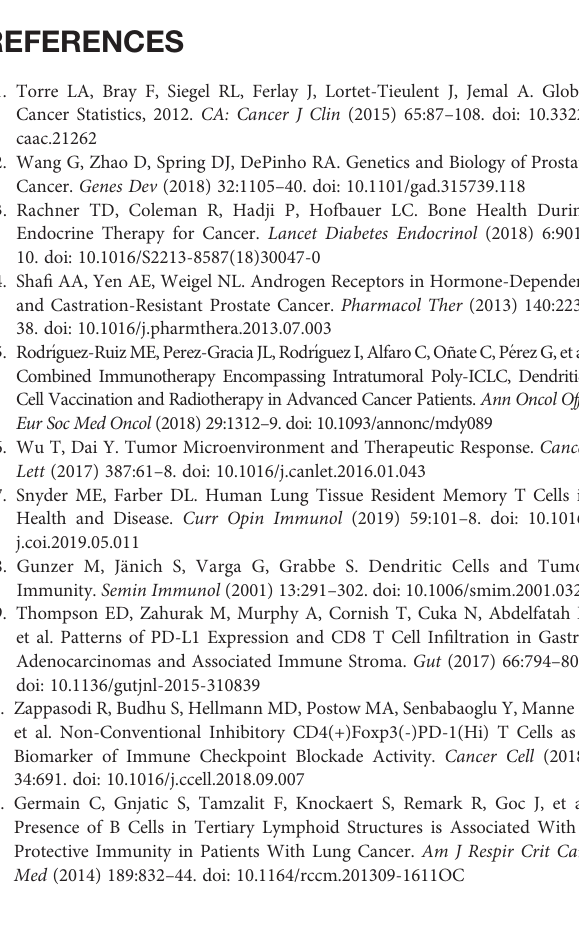
Supplementary Figure 2 | Kaplan-Meier survival curve of the top 10 immune terms. Supplementary Figure3 | Enrichment analysisof IRSsignaturewithalltheGSEA gene set. Supplementary Figure 4 | Three cluster identi fi ed in training cohort was validated in the validation cohort. Notes: (A) Kaplan-Meier survival curves showed that IRScluster2 had the best DFS prognosis, whereas IRScluster3 showed the worst prognosis. (B) IRScluster3 showed a lower TIDE value compared with that of IRScluster1 –